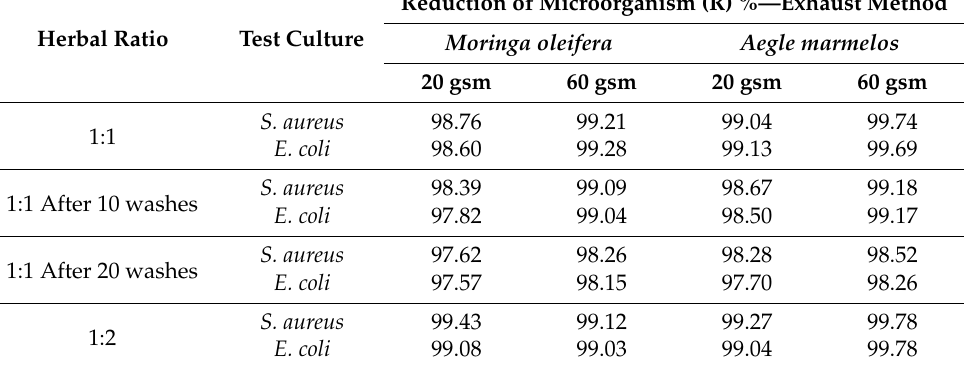
Table 3. Reduction of micro-organisms (AATCC 100)—Batch process (exhaust method).